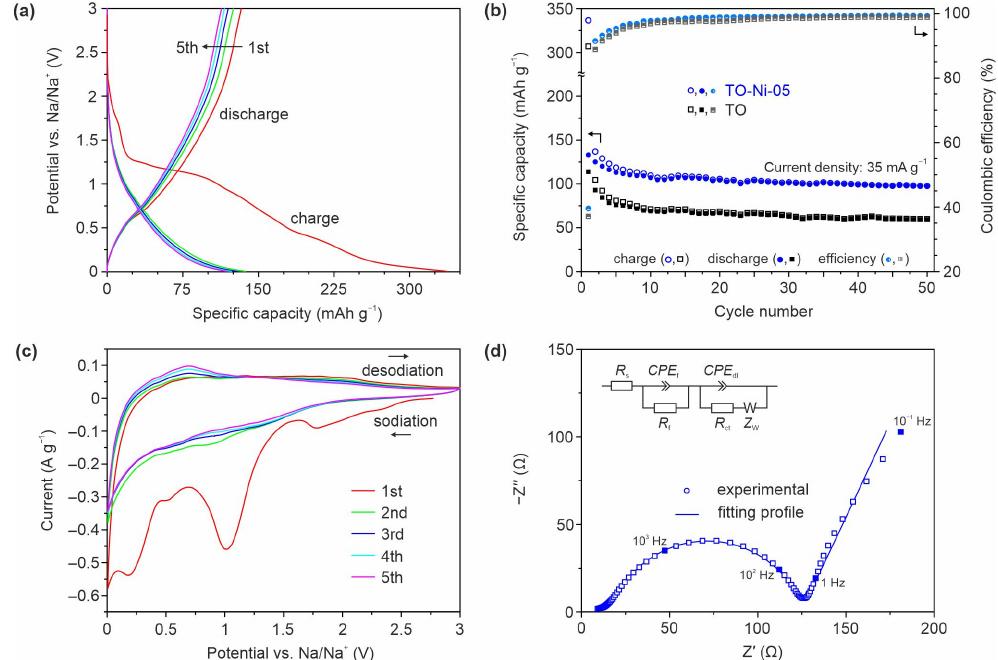
Figure 8. Sodium storage characteristics of analyzed TiO 2 (B) products. The five initial voltage profiles at 35 mA·g − 1 for the TO-Ni-05 material ( a ) and the corresponding correlation of its specific capacity with cycle number as compared to that for unmodified titanium dioxide ( b ). CV curves for Ni-doped TiO 2 (B) registered at a scan rate of 0.1 mV·s − 1 ( c ). Nyquist diagram for TO-Ni-05 electrode after five initial CV cycles and electrical equivalent circuit (inset) used for fitting the experimental data ( d ).